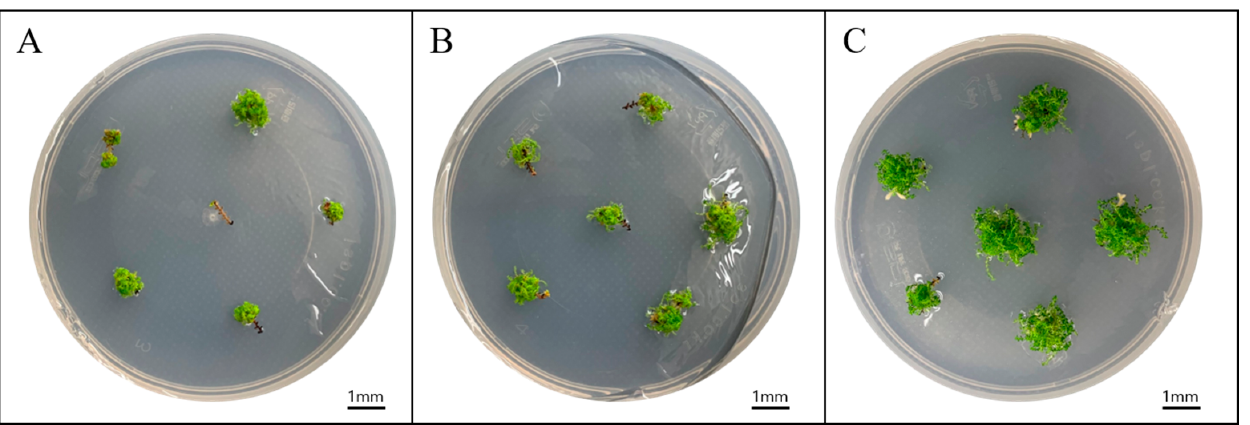
Figure 1. S. tamariscina (P.Beauv.) Spring sporophyte regeneration. Results according to different explant lengths: ( A ) 3 mm, ( B ) 6 mm, and ( C ) 12 mm after culturing for 12 weeks on 1/4 MS medium.